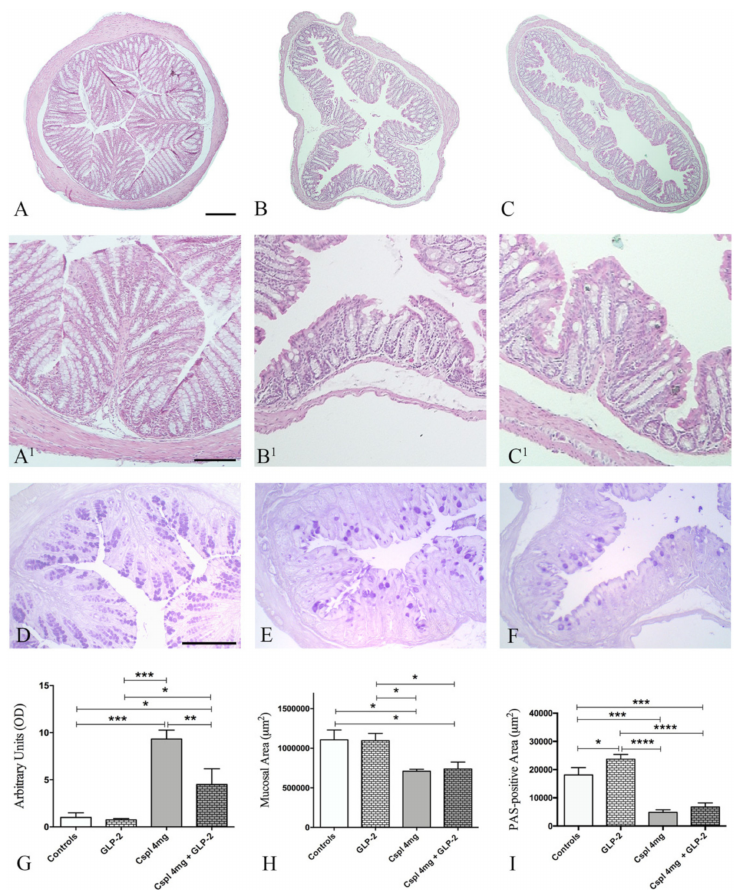
Figure 2. H&E ( A – C , A 1 – C 1 ) and PAS ( D – F ) staining of mouse distal colon. Controls ( A , A 1 , D ), cisplatin ( B , B 1 , E ) and cisplatin + [Gly2]GLP-2 ( C , C 1 , F ) group. Scale bar: ( A – C ) = 200 µ m, ( A 1 – C 1 ) = 120 µ m; D – F = 100 µ m. Score analysis of mucosal damage ( G ), quantitative analysis of the mucosal area ( H ) and quantitation of PAS staining ( I ). Score analysis ( G ) was performed as described in Materials and Methods. Values are the median ± interquartile range. Non-parametric ANOVA, Kruskal–Wallis, post hoc Dunn’s test. The quantitation of mucosal area ( H ) was done on the whole transverse colonic surface. Data are expressed as mean ± SEM. One-way ANOVA test, post hoc Dunn’s test. The measurement of PAS staining was done on 10 ROIs randomly chosen from the total mucosal area. Data are expressed as mean ± SEM. One-way ANOVA test, post hoc Newman Keuls’ test. **** ( p < 0.0001), *** ( p < 0.001), ** ( p < 0.01), *( p < 0.05). n = 4–6 for each group.